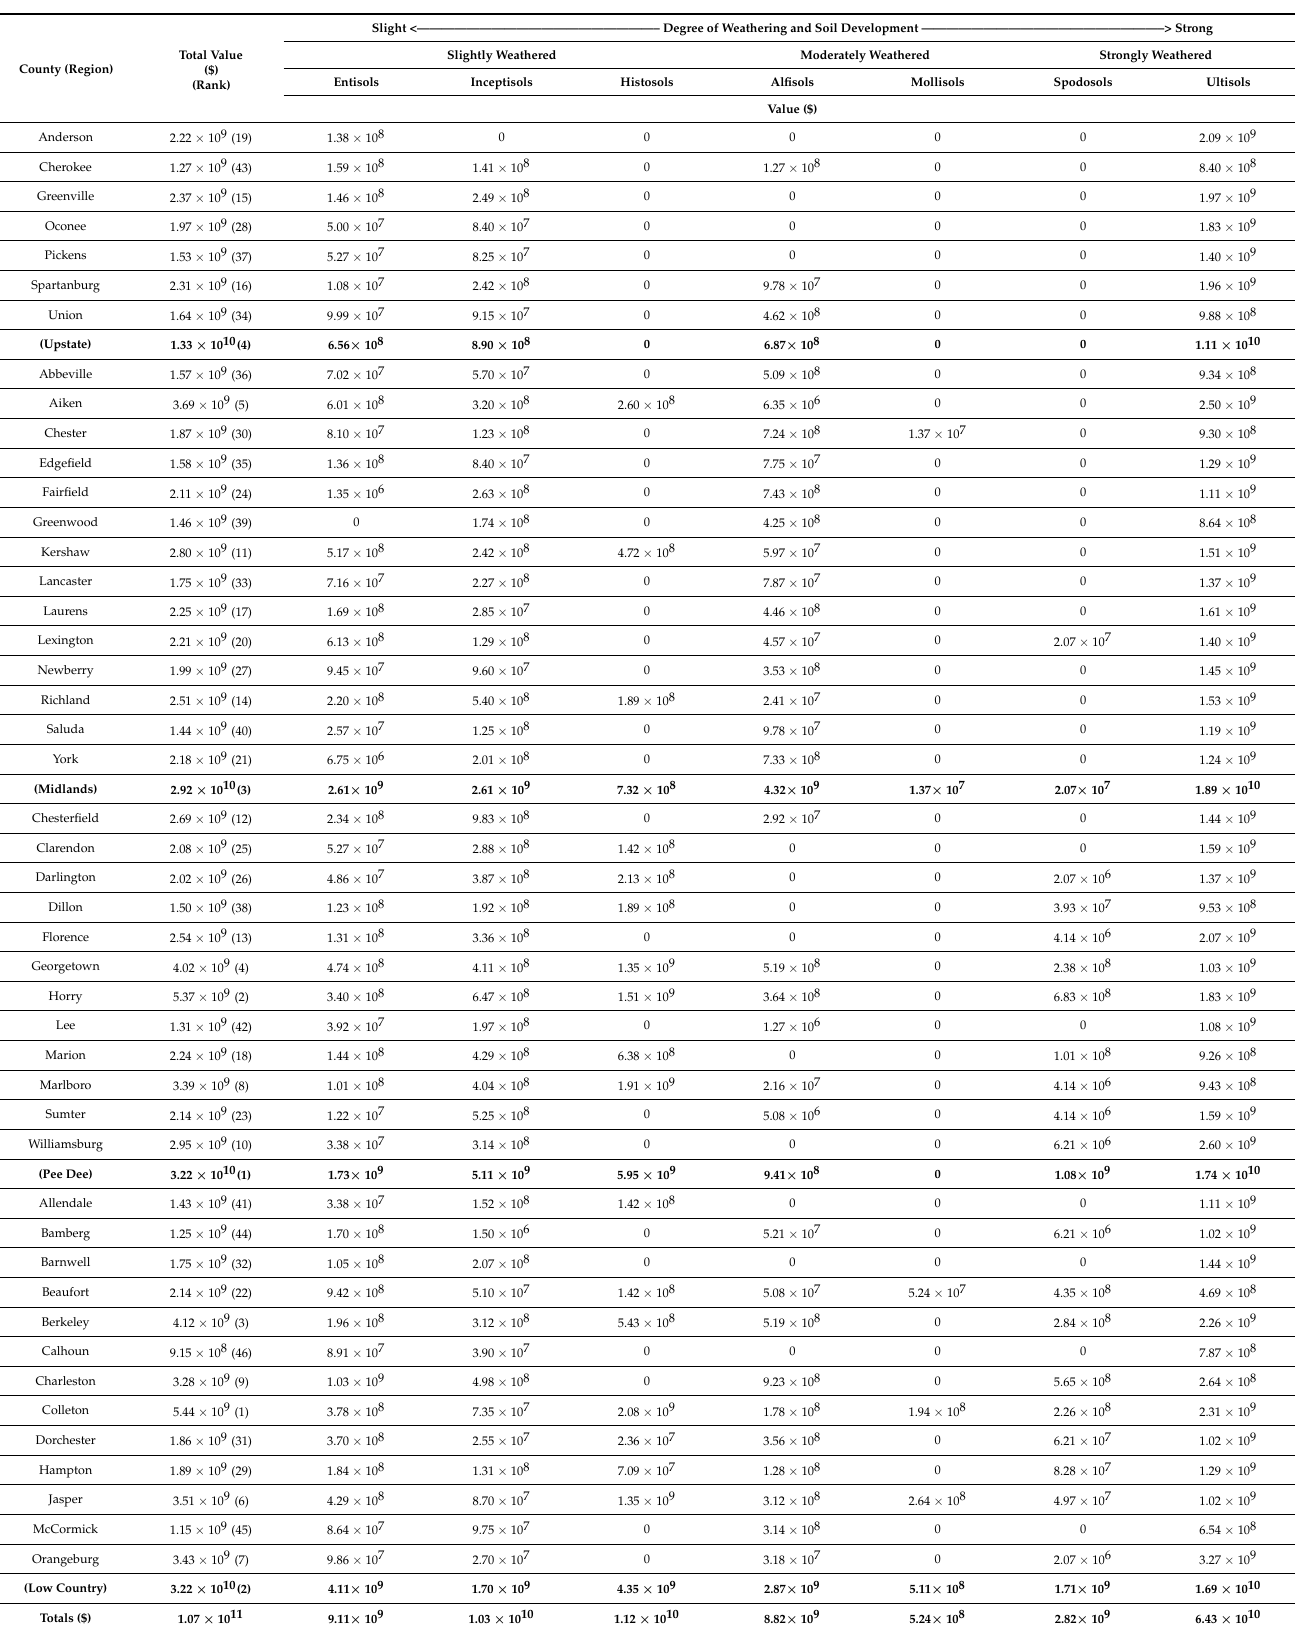
Table 6. The total dollar value of soil organic carbon (SOC) by county, region, and soil order for the state of South Carolina (U.S.A.), based on mid-point soil organic carbon (SOC) numbers for the upper 2 m from Guo et al. 2006 [18] and a social cost of carbon (SC-CO 2 ) of $46 per metric ton of CO 2 (2007 U.S. dollars with an average discount rate of 3% [17]).